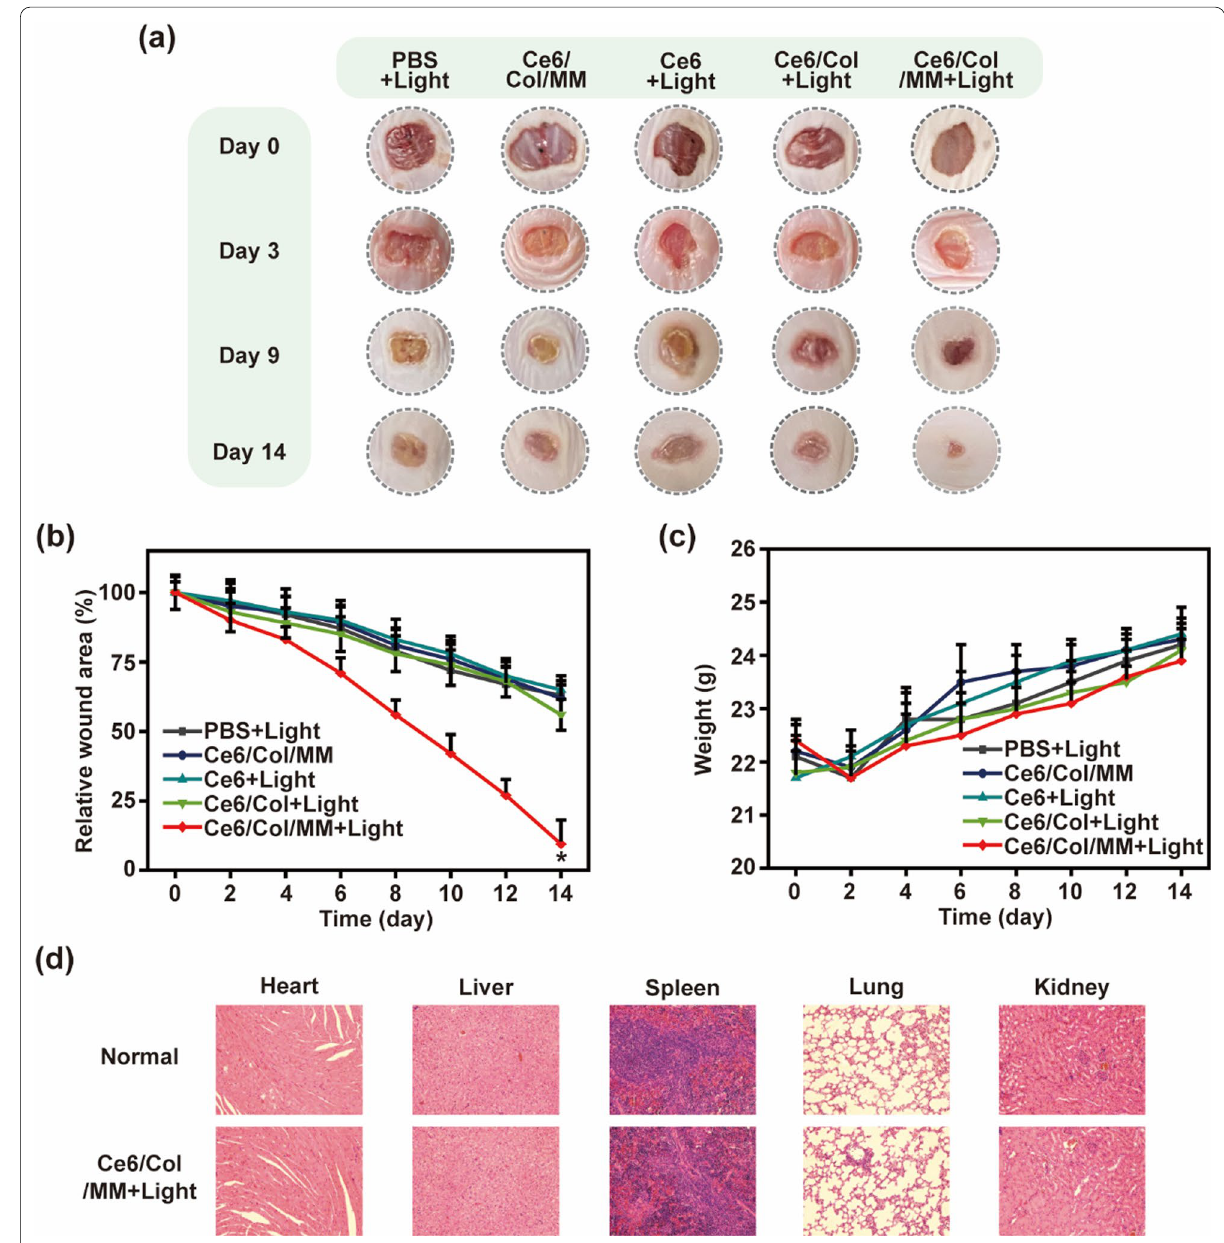
Fig. 6 Healing effect and histological biocompatibility of MRSA-infected wound mice received various treatments as indicated. a Photographs of wound region at predetermined time points. b Relative wound area and c body weight of mice with above mentioned treatments. d H&E-stained sections of major organs (heart, liver, spleen, lung and kidney) of Ce6/Col/MM-treated mice. Scale bar: 100 μm. Data are shown as means (n 6). * p < 0.005 compared to the Ce6 Light = +